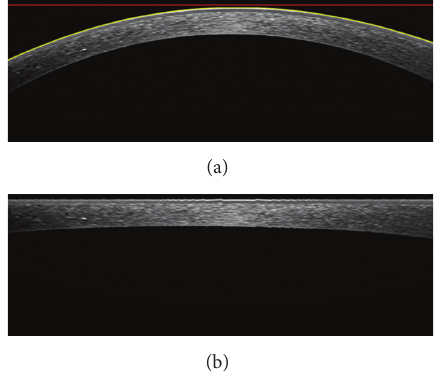
Figure 11: (a) Output of Level Set. (b) The estimated Bowman boundary.